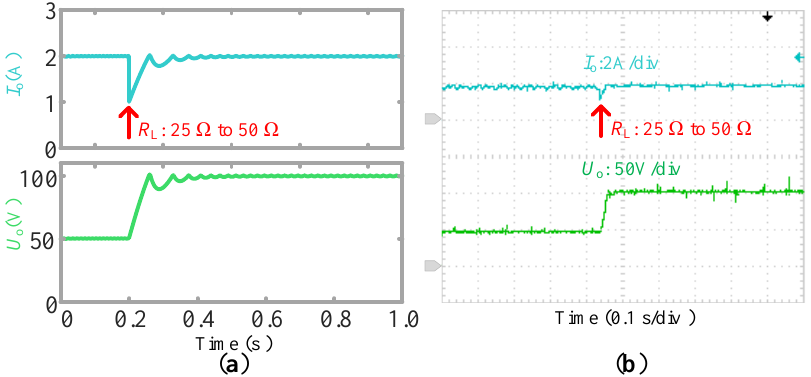
Figure 16. Simulated and experimental CC power transfer results of APC system: ( a ) simulated; and ( b ) experimental. I o , output current (blue lines); U o , output voltage (green lines).